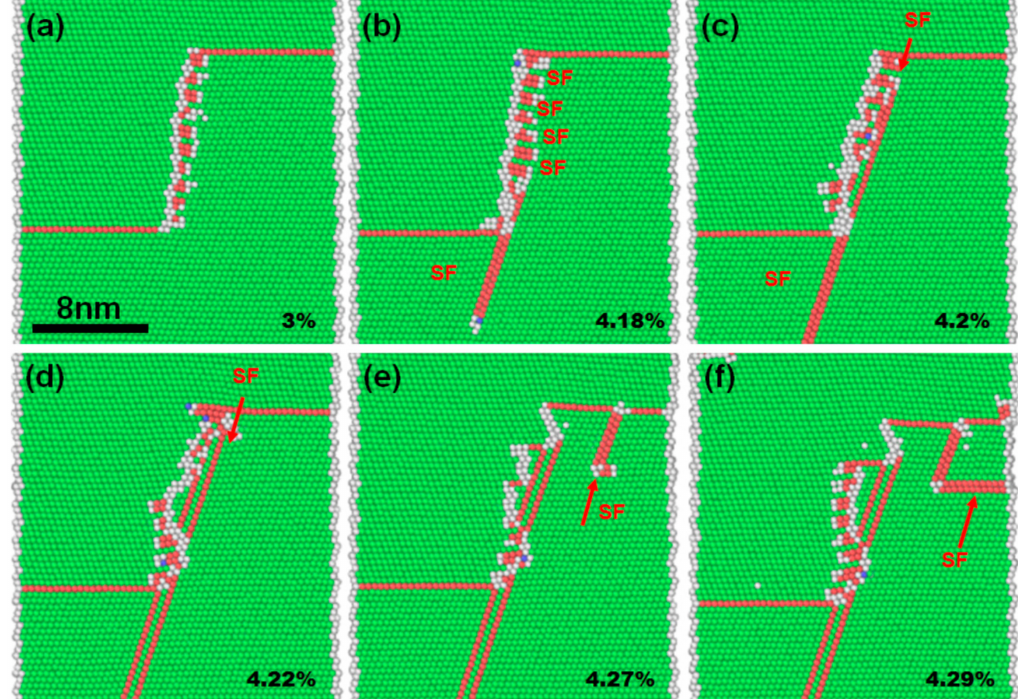
Figure 6. Series of images showing the deformation process of twin-structured Cu nanocrystal: ( a – d ) the partial dislocations at the ITB glide into the FCC lattice, leading to periodical sets of short SFs observed at the ITB; ( e ) the ITB serves as a partial dislocation source; ( f ) direct observation of partial dislocations emitted from ITB or the tips of